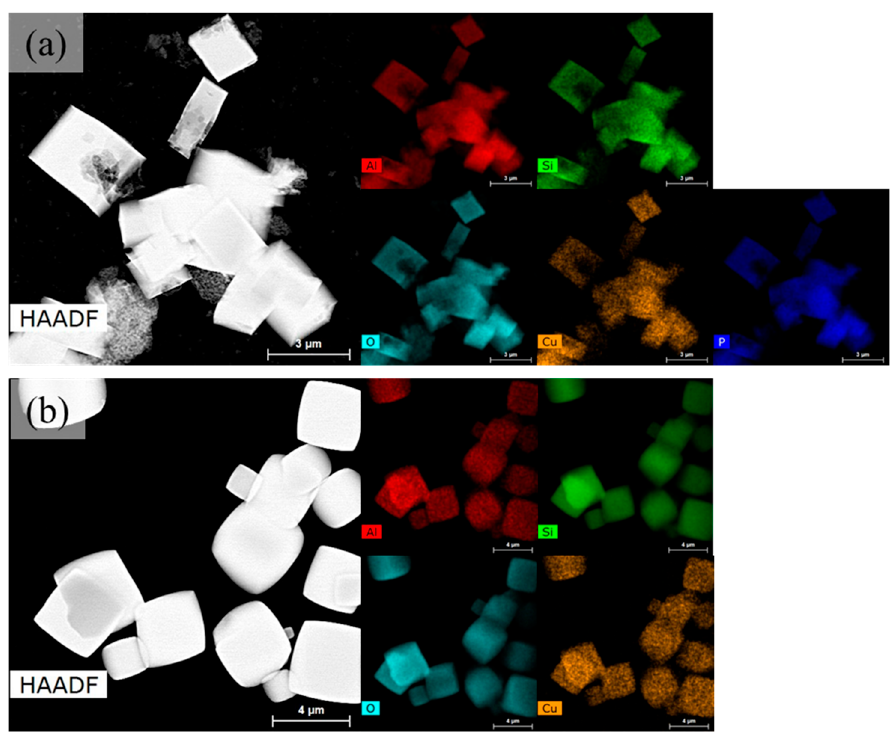
Table 2. Composition obtained with EDX mapping of HR-TEM.